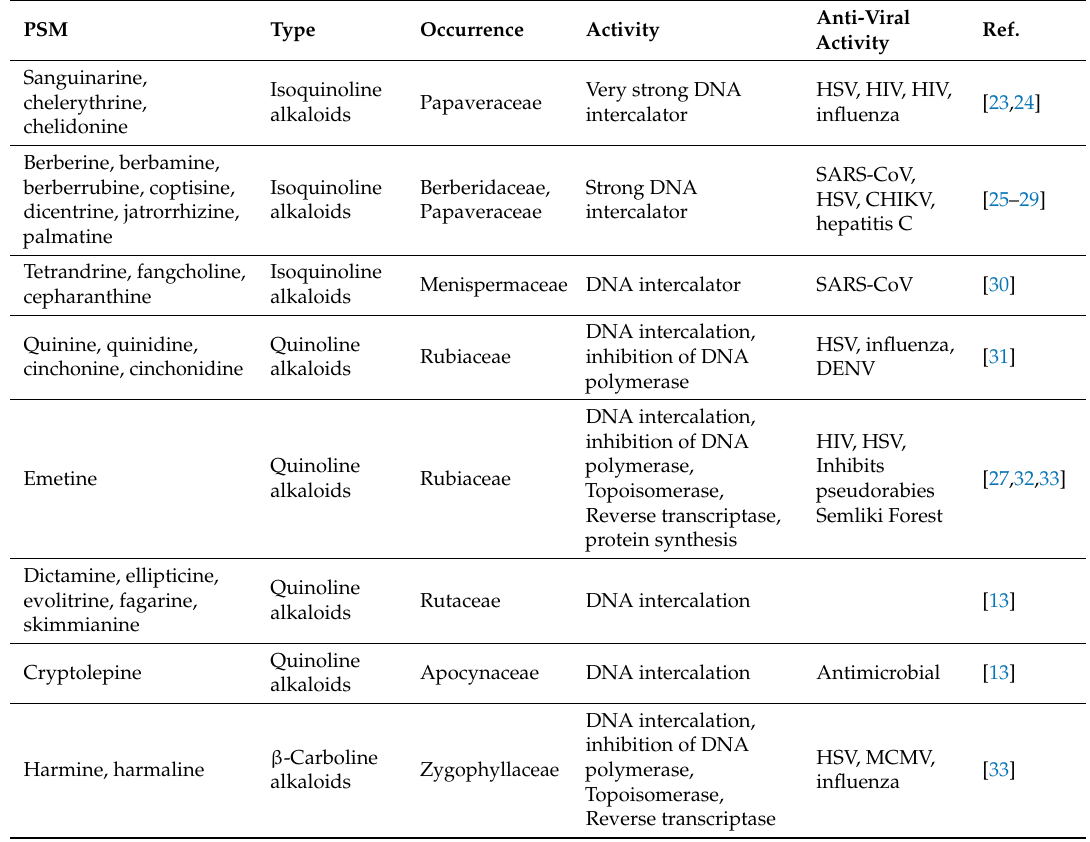
Table 3. Selected alkaloids, which intercalate nucleic acids and inhibit viral replication [19–22].